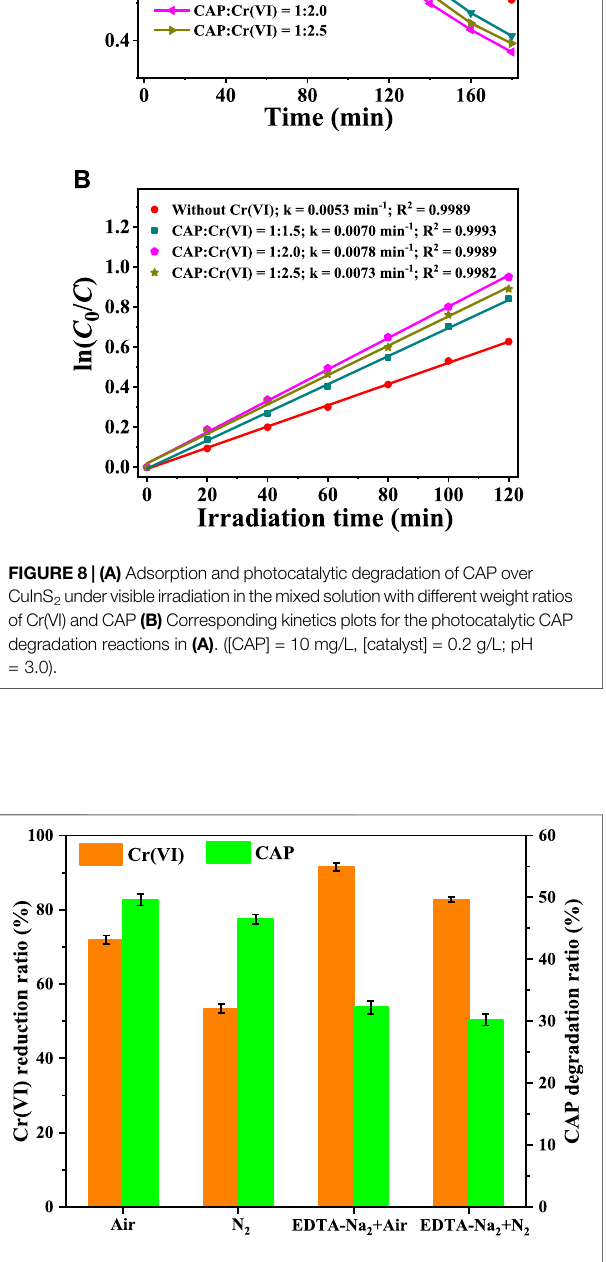
FIGURE 9 | Cr(VI) reduction and CAP degradation over CuInS 2 in the Cr(VI)/CAP mixed solution under air or N 2 condition as well as with or without the addition of EDTA-Na 2 . ([Cr(VI)] = 10 mg/L, [CAP] = 10 mg/L, [catalyst] = 0.2 g/L, pH = 3.0, visible-light irradiation time = 120 min).